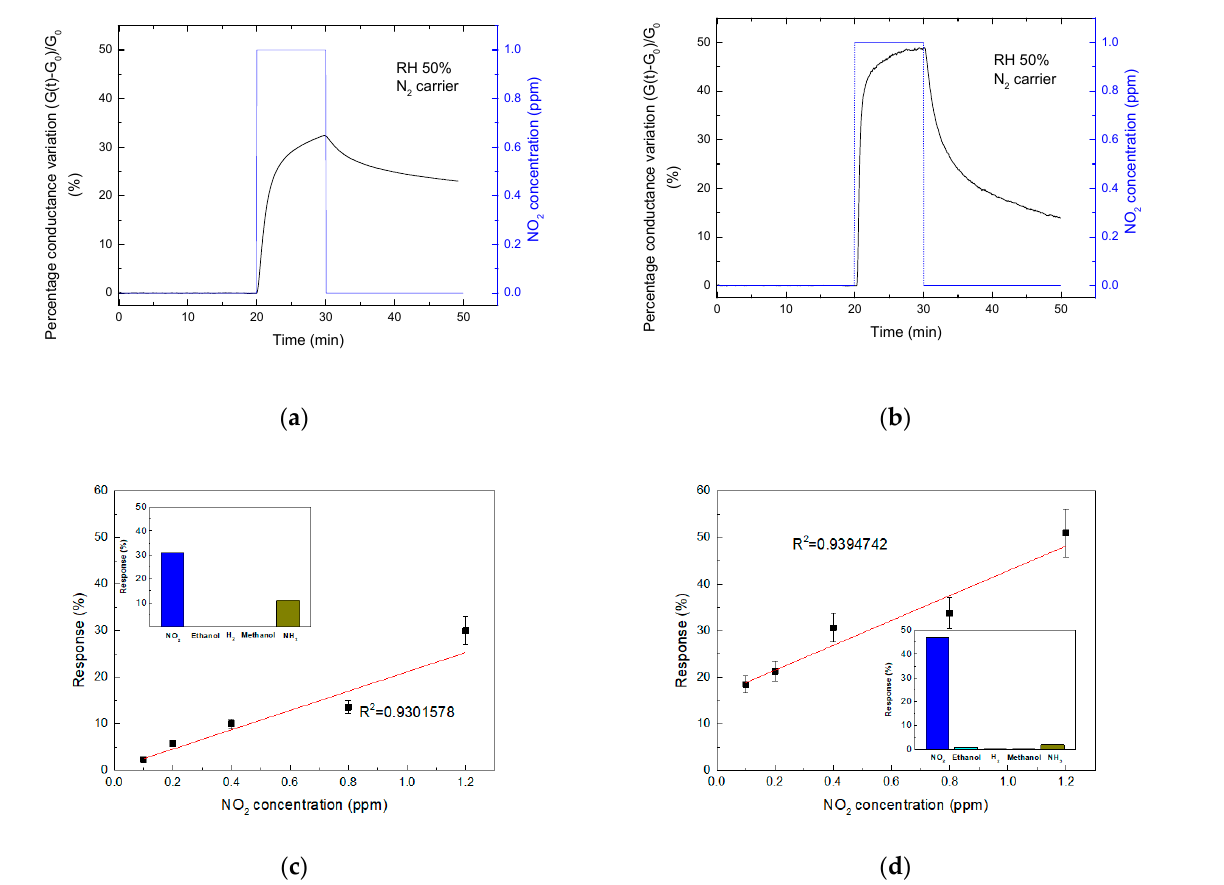
Figure 14. Sensing responses to a single pulse of 1000 ppb NO 2 of chemiresistors based on graphene ( a ) and ZnO decorated graphene ( b ). Sensing response of the graphene-based device ( c ) and of the device based on the ZnO functionalized graphene ( d ) in the range 0.1–1.2 ppm NO 2 ; the linear regression is reported as red line along with the regression coefficient. In the insets the selectivity towards 1 ppm NO 2 , 50 ppm ethanol, 1% hydrogen (H 2 ), 50 ppm methanol and 250 ppm ammonia (NH 3 ) of both materials.